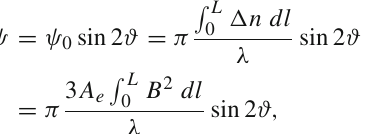
Fig. 1 A polarimeter based on a Fabry–Perot cavity with a time- dependentsignalandheterodynedetection. PDE extinctionphotodiode; PDT transmission